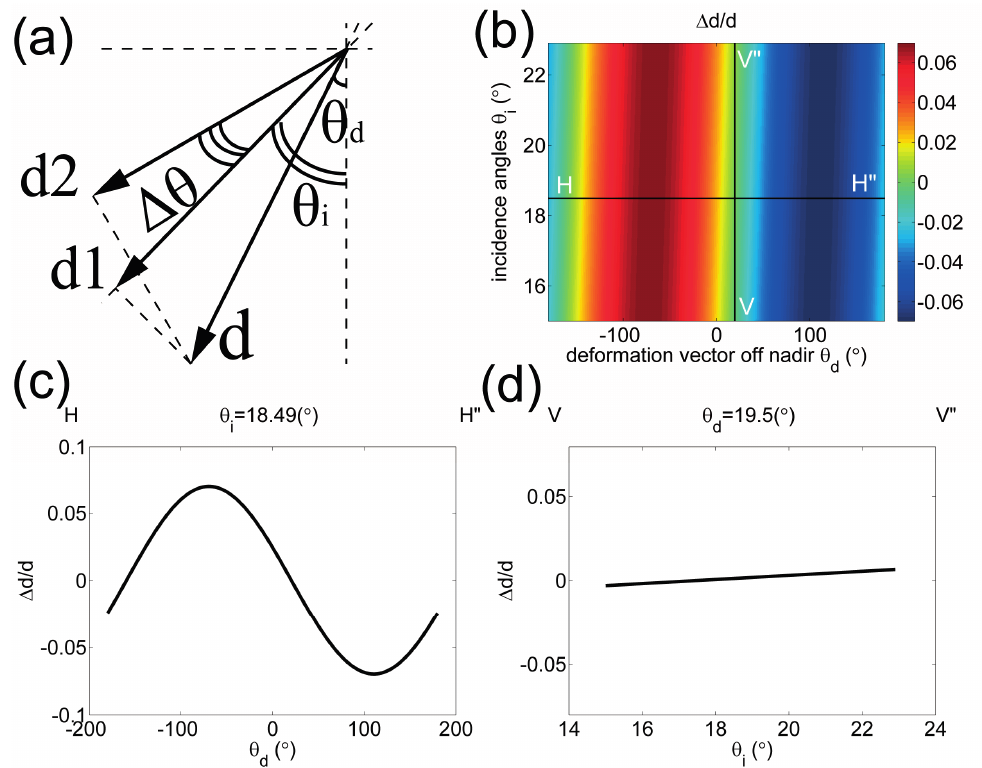
Figure B1. The ratio (r Δθ ) of LOS displacement differences to the actual displacement. ( a ) incidence angle geometries. ( b ). r Δθ in terms of θ d and θ i in this case. ( c ) r Δθ in profile HH". ( d ). r Δθ in profile